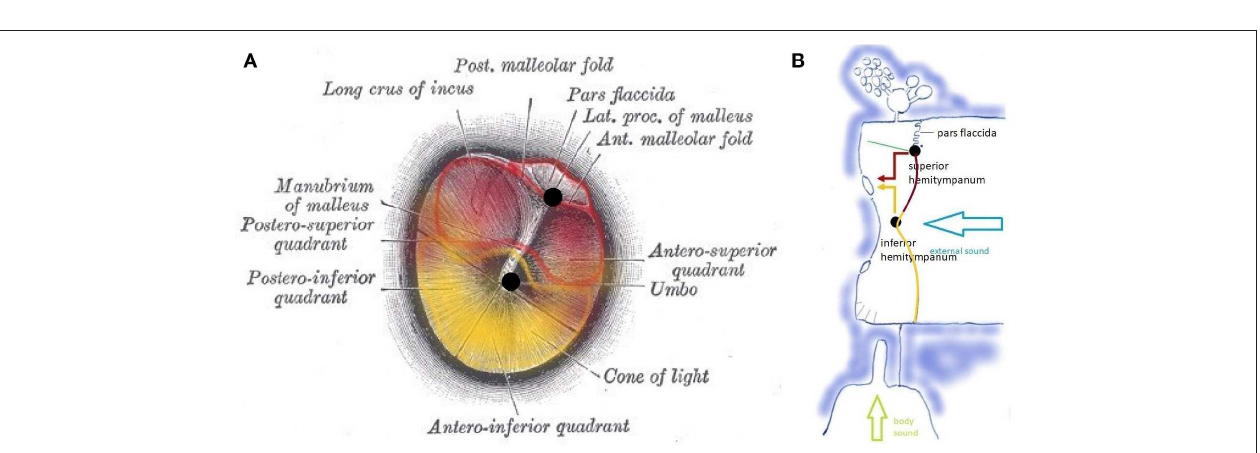
FIGURE 4 | (A) Tympanic membrane with a pars flaccida and pars tensa. Functionally, the pars tensa contains two separate entities or “hemitympani” which roughly coincide with the upper and lower half of the TM. Upper hemitympanum: red; lower hemitympanum: yellow; (from Gray’s anatomy via Wikipedia). (B) Vibrations of the upper hemitympanum, related to lower frequencies (red arrow) are mainly transmitted via the superior tympano-mallear connection (upper black dot), those of the lower hemitympanum, related to mid-frequencies (yellow arrow) via the inferior tympano-mallear connection (lower black dot).